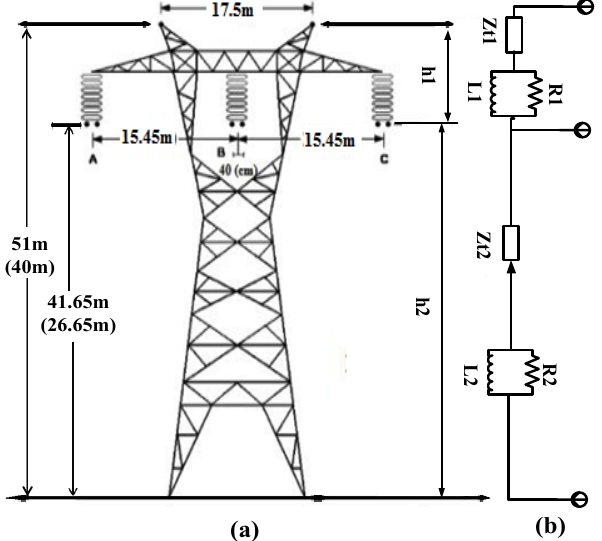
Figure 2: (a) Tower configuration (values in brackets are midspan heights), (b) multistory model of transmission tower .